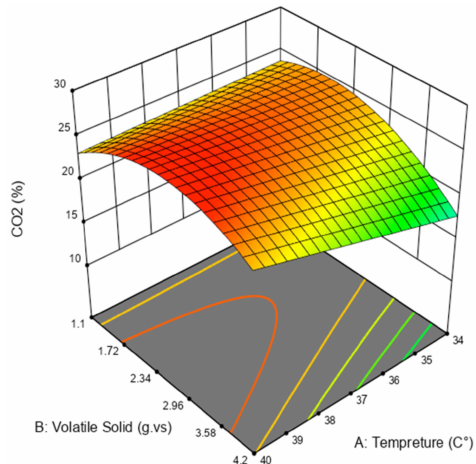
Figure 16. 3-D surface plot presents the effect of temperature and volatile solid on CO 2 % at sludge quantity of